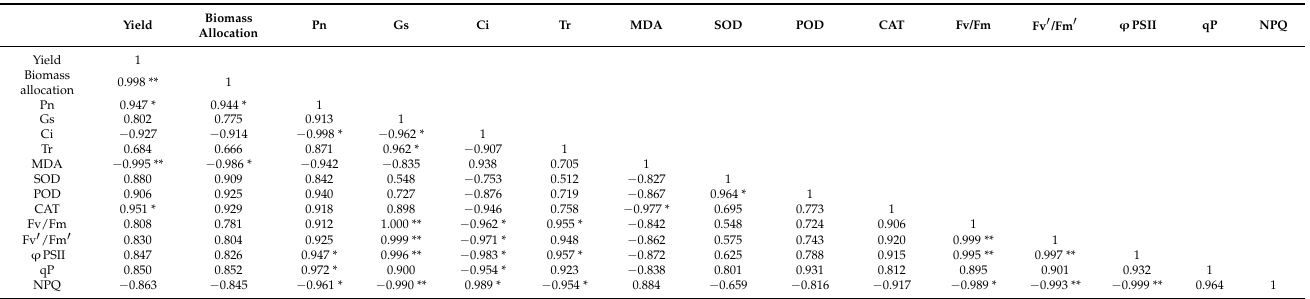
Table 3. Correlation between photosynthesis and antioxidant activity of P.